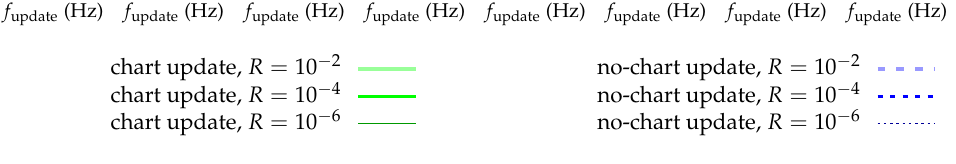
Figure 7. Mean of the performance metric for each approach. Results from the approach in which we apply the chart update, and those of which we do not apply it are plotted together. Bars represent the confidence interval (3 σ ) in the mean